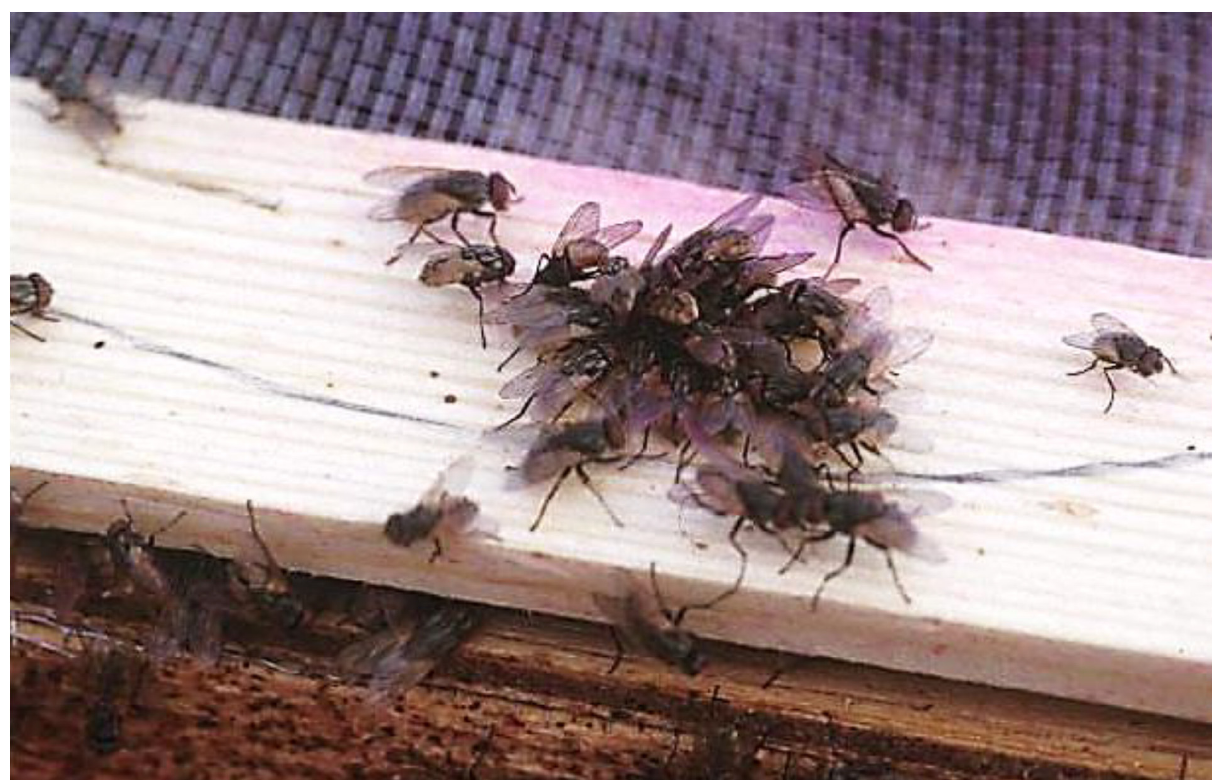
Figure 7. Target insecticides to congregation sites for adult house flies.